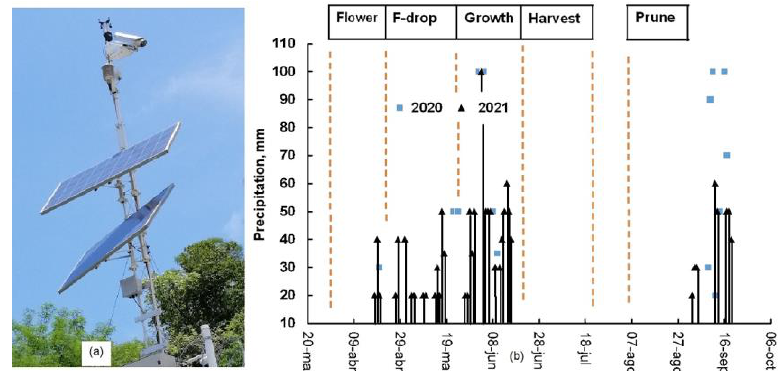
Figure 2. Climatic ( a ) station, and ( b ) precipitation during 2020 and 2021.